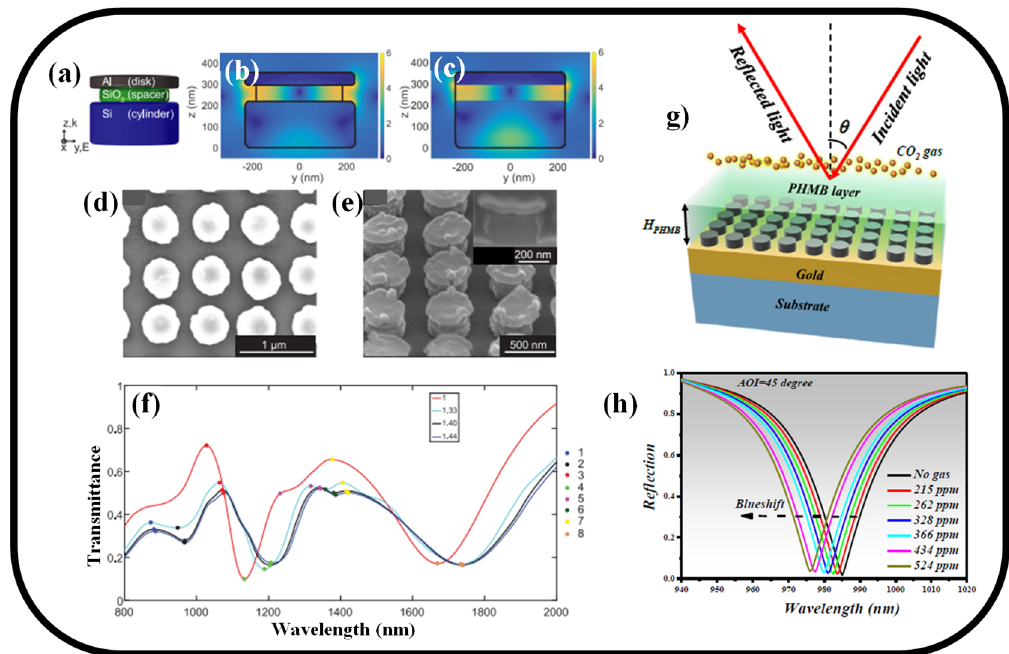
Figure 7. ( a ) The hybrid nanoantenna's shape with its 50 nm SiO 2 undercut. E-field amplitude enhancement surface plots ( b ) with and ( c ) without a 50 nm undercut in the SiO 2 . Reprinted with permission from Ref. [144] ( d ) A top view SEM photo of a hybrid nanoantenna array with a 670 nm period. Reprinted with permission from Ref. [144], ( e ) SEM picture of the hybrid nanoantenna array, tilted 52° to show the undercut in the SiO 2 spacer. The cross-section of a single nanoantenna created via FIB is seen in the inset. Reprinted with permission from Ref. [144], ( f ) Experimental transmittance for four distinct background circumstances for bulk RI detection using a hybrid nanoantenna with a 50 nm undercut in the SiO 2 . Reprinted with permission from Ref. [144], ( g ) Schematic representation of hybrid MS covered with PHMB layer for gas sensing application [83], ( h ) Reflection spectrum versus CO 2 gas concentration [83].